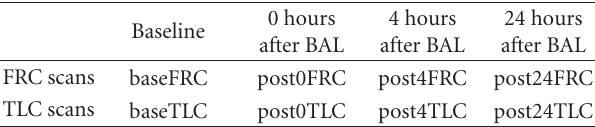
Table 1: Eight CT scans acquired from four phases for each subject. 0 hours 4 hours 24 hours Baseline after BAL after BAL after BAL FRC scans baseFRC post0FRC post4FRC post24FRC TLC scans baseTLC post0TLC post4TLC